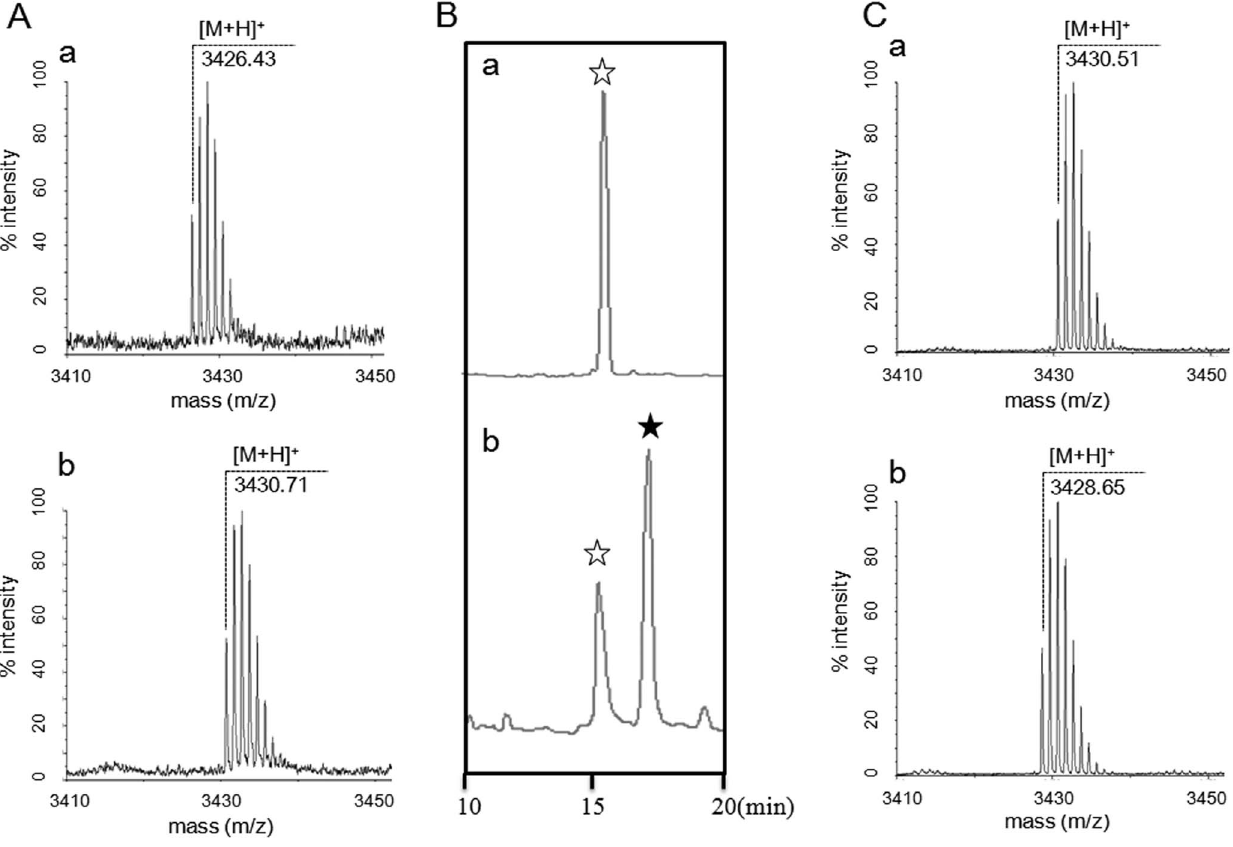
Figure 4. MS and HPLC analysis of bovicin HJ50 and its invitro produced counterparts. (A) a, bovicin HJ50 produced by BovM in vitro in the absence of DTT; b, main product produced by BovM in vitro in the presence of DTT. (B) a, HPLC analysis of reduced bovicin HJ50; b, HPLC analysis of reduced bovicin HJ50 after exposed to air for 2 days. The white star indicated reduced bovicin HJ50 and the black star indicated the wild type bovicin HJ50. (C) MS analysis of reduced bovicin HJ50 (a) and wild type bovicin HJ50 (b).